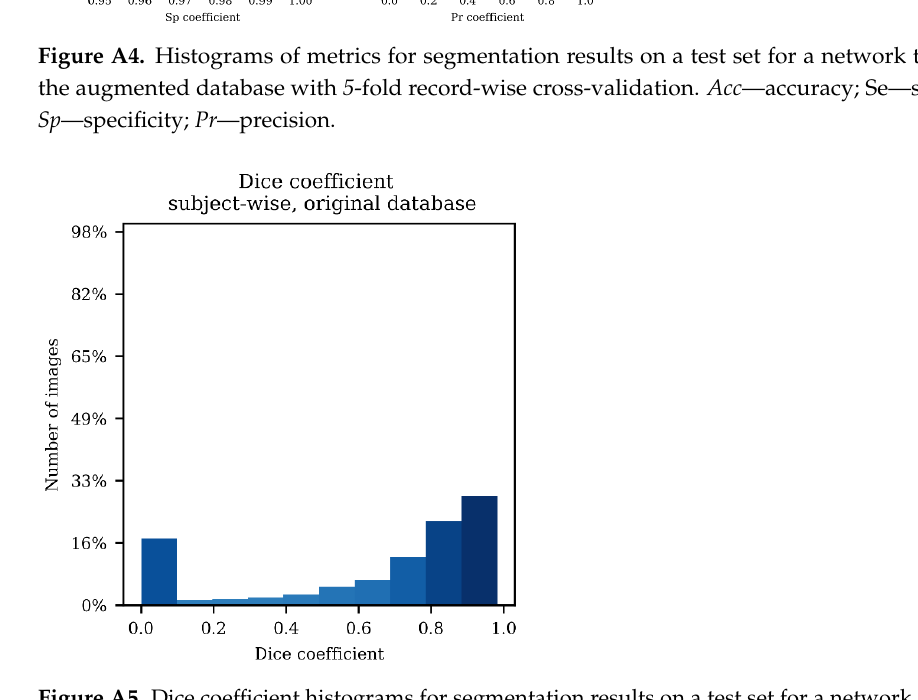
Figure A5. Dice coefficient histograms for segmentation results on a test set for a network trained on the original database with 5 -fold subject-wise cross-validation.